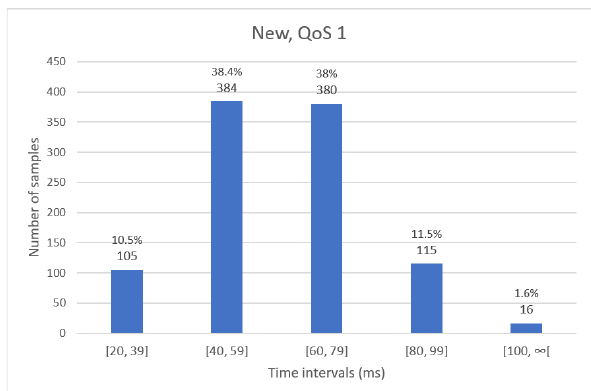
Figure 7. Delay distribution for the test performed with the new smart home network and MQTT QoS 1.